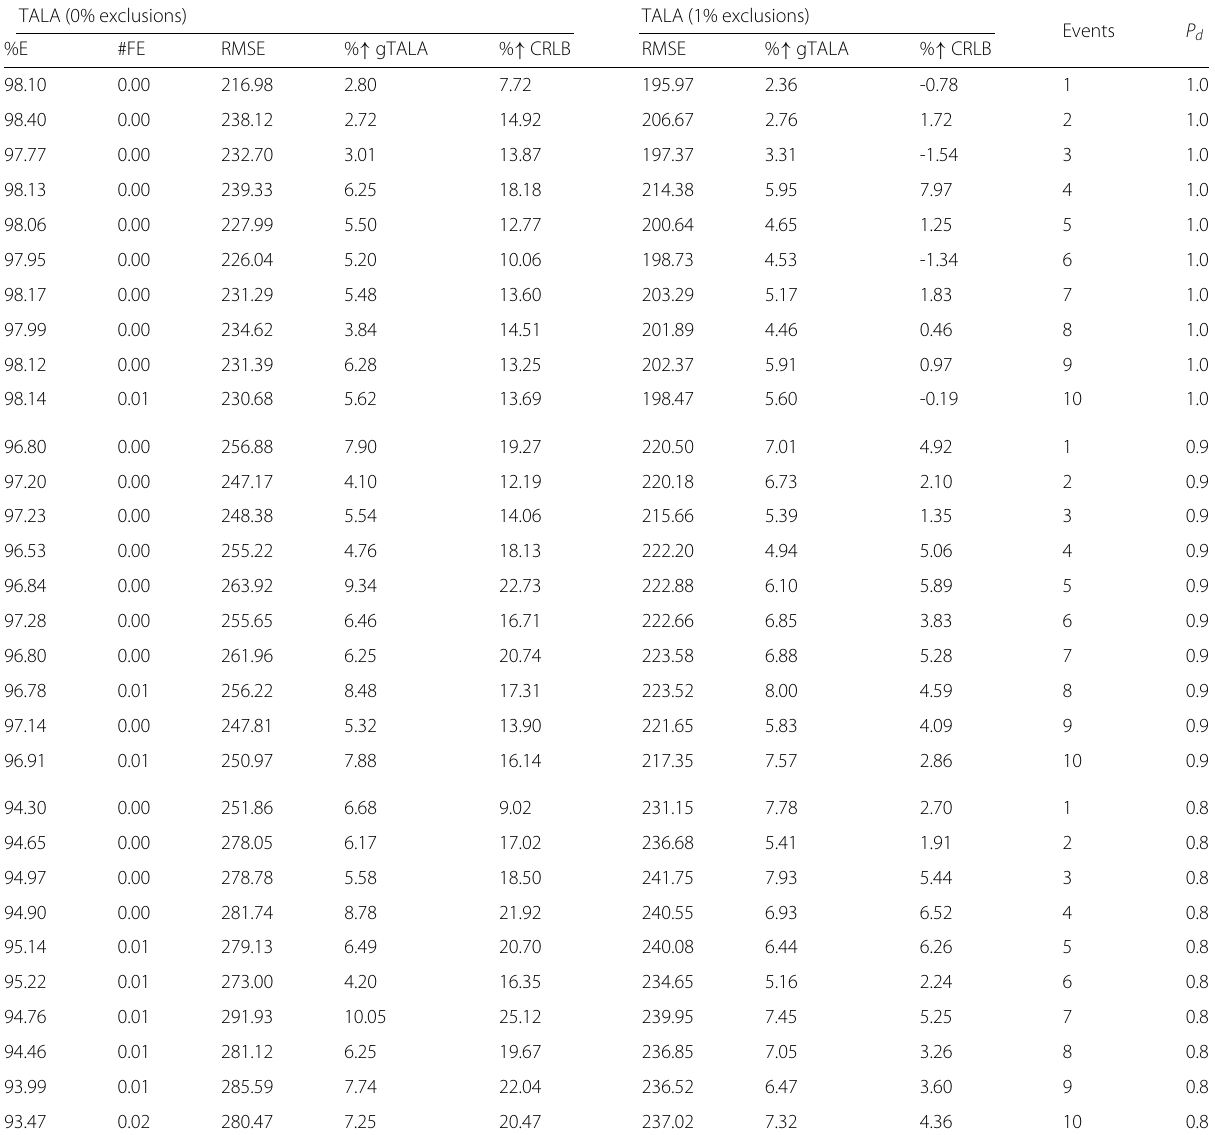
Table 3 Summary of the TALA geo-location performance for scenario 1 TALA (0%